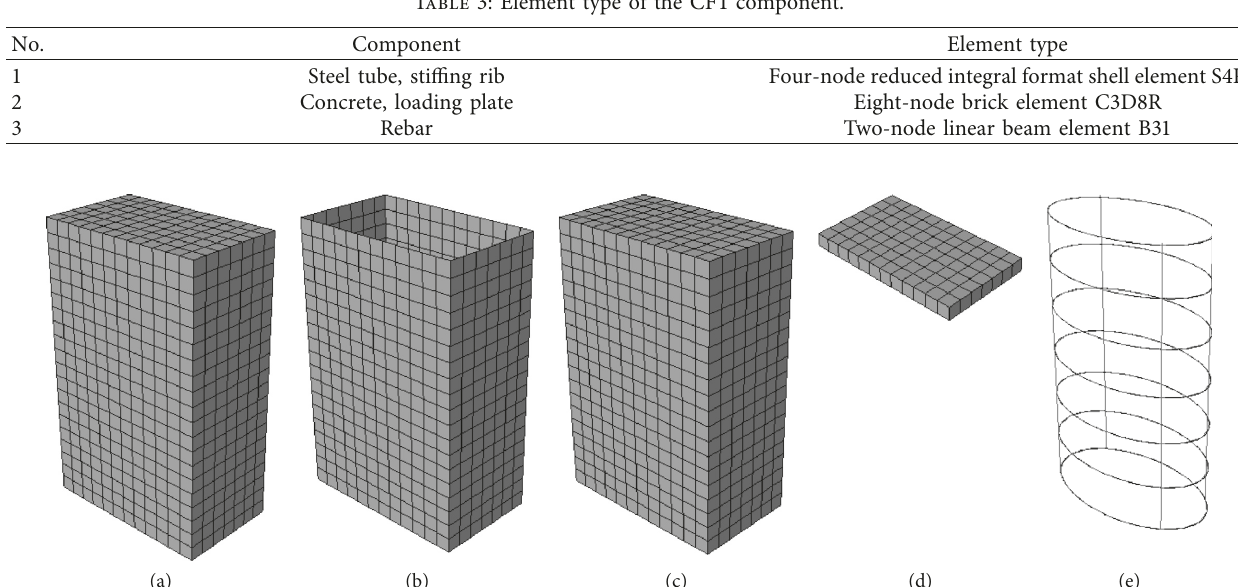
Figure 7: FE model of the CFT columns. (a) 1/2 total model, (b) steel pipe, (c) concrete, (d) loading plate, and (e) stirrup.